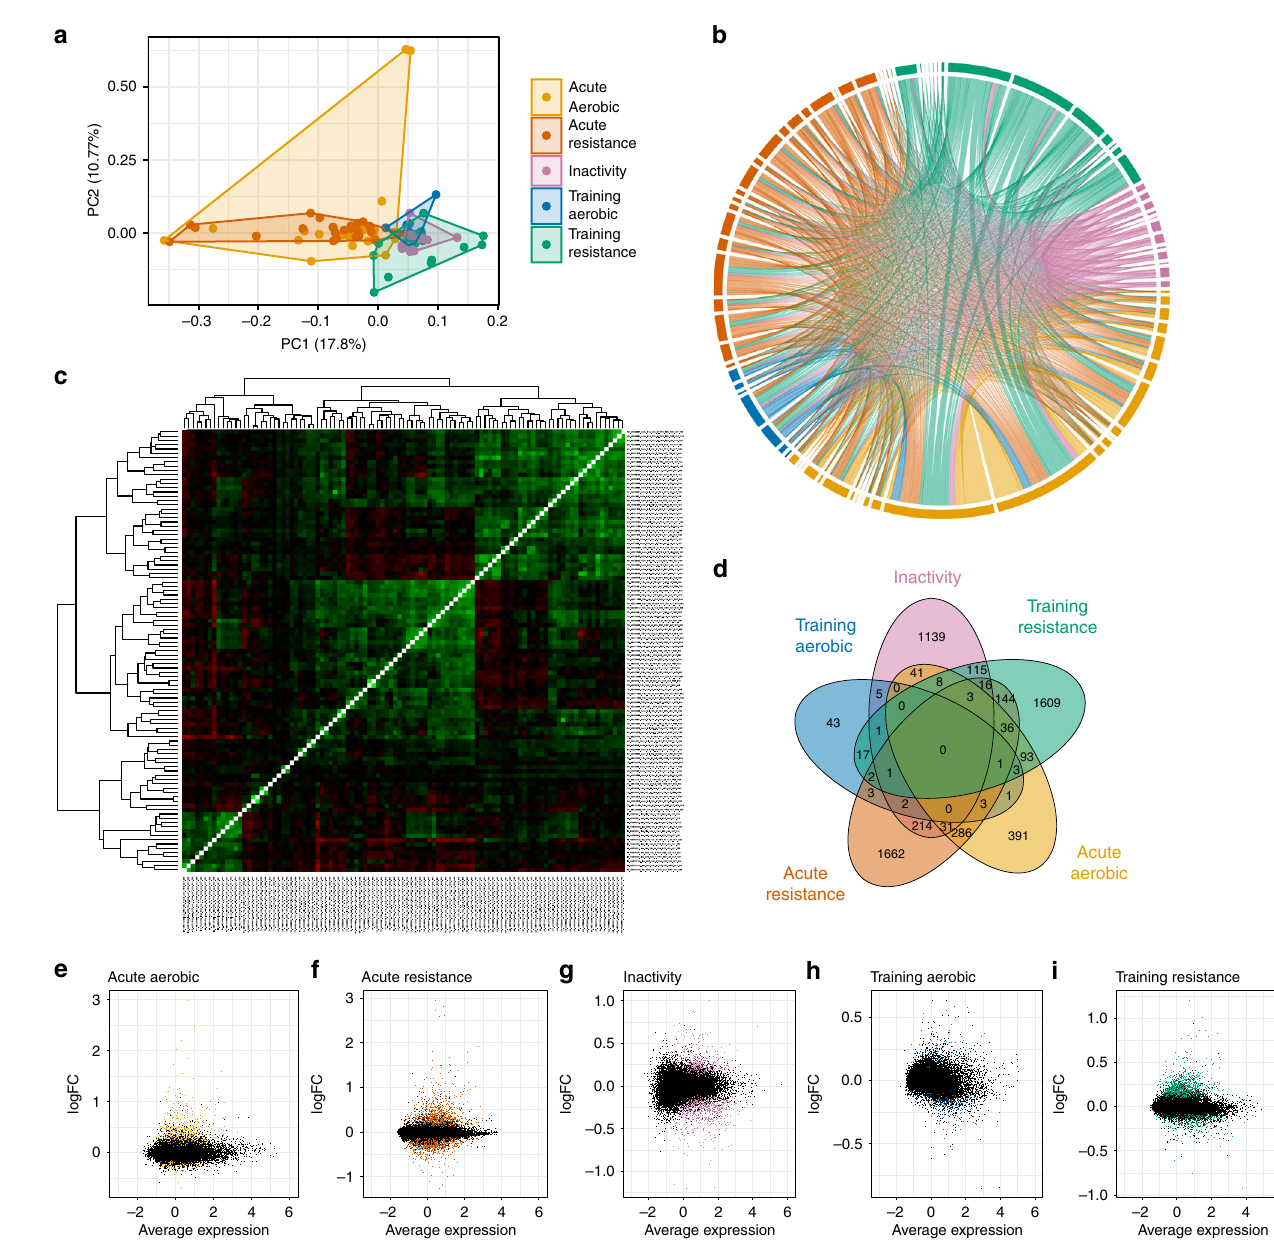
Fig. 2 Inter-array comparisons separate acute exercise from training and inactivity. All datasets of healthy individuals were compared with each other using a principle component analysis ( a ), a chord plot ( b ) and a correlation matrix of fold-changes ( c ). A Venn Diagram presents the overlap of the signi fi cantly (FDR < 1%) expressed genes ( d ). All genes are presented in M-plots ( e – i ) with signi fi cantly changed genes (FDR < 1%) represented with colored